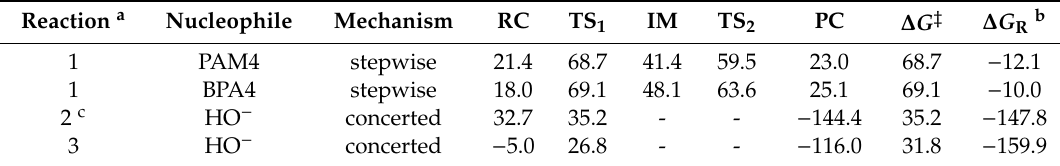
Table 2. Computed mechanisms, kinetic (RC, reactant complex; TS, transition state; IM, intermediate; PC, product complex) and thermodynamic ( ∆ G R COMP ) parameters for the specified reactions at 25 ◦ C, with energies in kJ · mol − 1 . The reference point for all reactions is the energy of the isolated reactants. Reaction